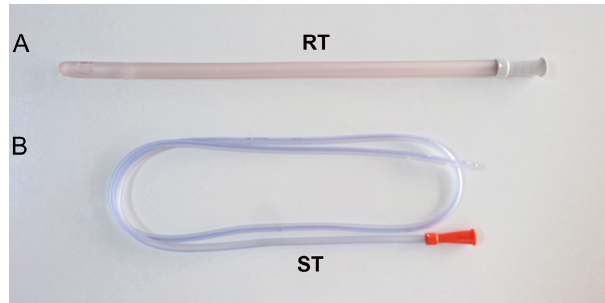
Figure 1. Flatus tubes (RT, rectal tube; ST, sigmoidal